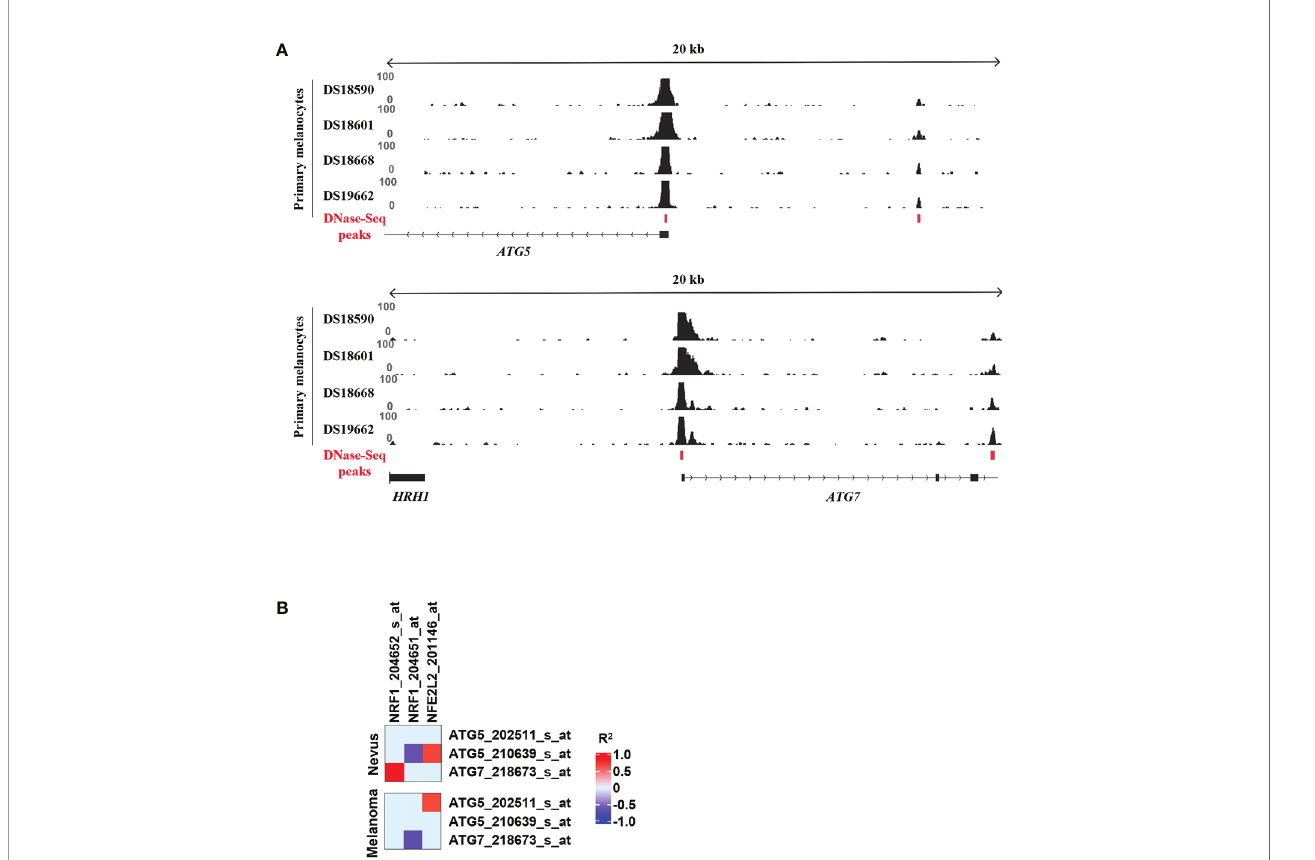
FIGURE 4 | Selection of TFs with highest af fi nity scores for ATG5 and ATG7 promoters. (A) Prediction of binding of TFs to regulatory regions of ATG5 and ATG7 using the TEPIC tool. TF af fi nity scores were computed in the overlap of all DNase-seq identi fi ed open-chromatin peaks across the replicates in the proximity of the gene-transcription start site with TEPIC. DNase-seq data from all replicates are shown. (B) Heatmap of the GSE3189 gene-expression pro fi le showing the correlation between NRF1 and NFE2L2 and ATG5 and ATG7 . R 2 values higher than 0.5 are coded in red and values lower than -0.5 are coded in blue in the Figure continuous scale. Individual probe sets for each gene are